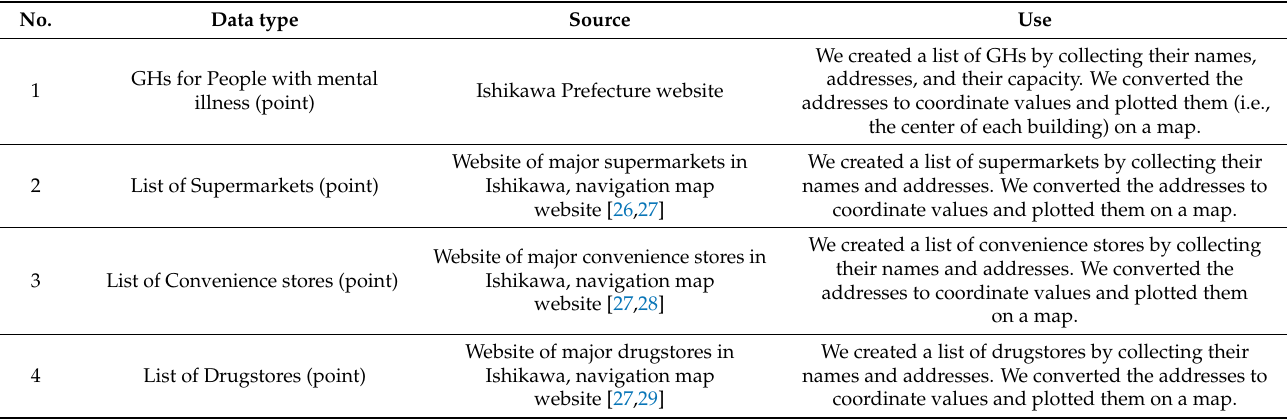
Table 1. Data sources used for